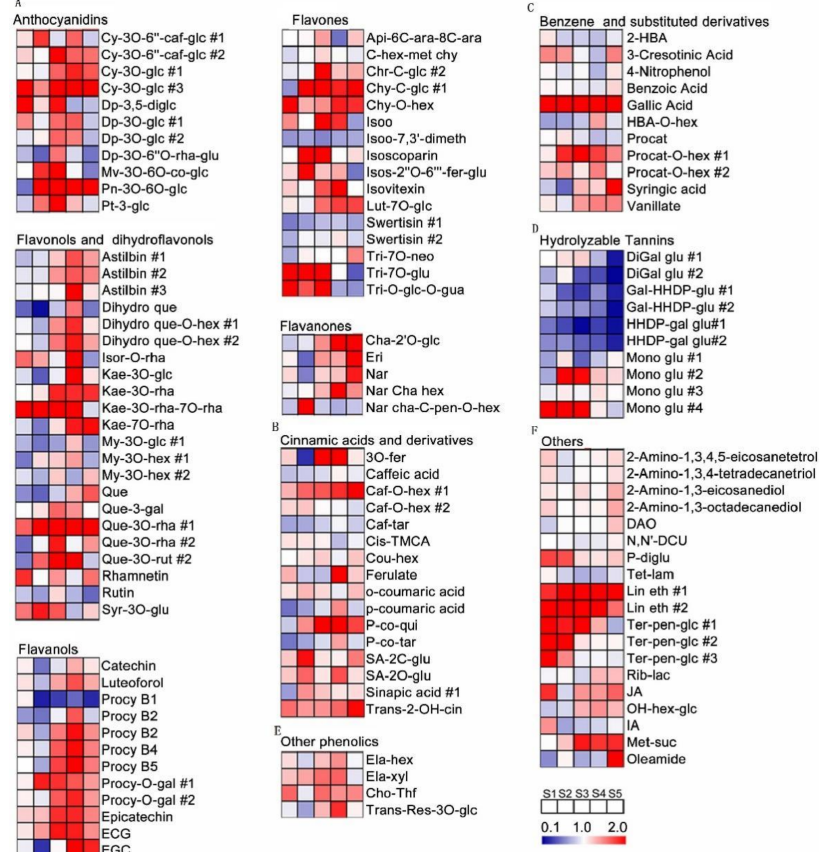
Figure 5. Heatmap of the secondary metabolite changes in pulp of developing berries under RR cultivation as compared with those in RC (RR vs. RC). ( A ) Flavonoids, including anthocyanins, fla- vanols, flavanones, flavones and flavonols and dihydraflavonols; ( B ) cinnamic acids and derivatives; ( C ) benzene and substituted derivatives; ( D ) hydrolysable tannins; ( E ) other phenolics; ( F ) others. RR and RC are the abbreviations of root restriction and traditional cultivation, respectively. A t -test was performed for statistical analysis. Each data was the mean value of three biological